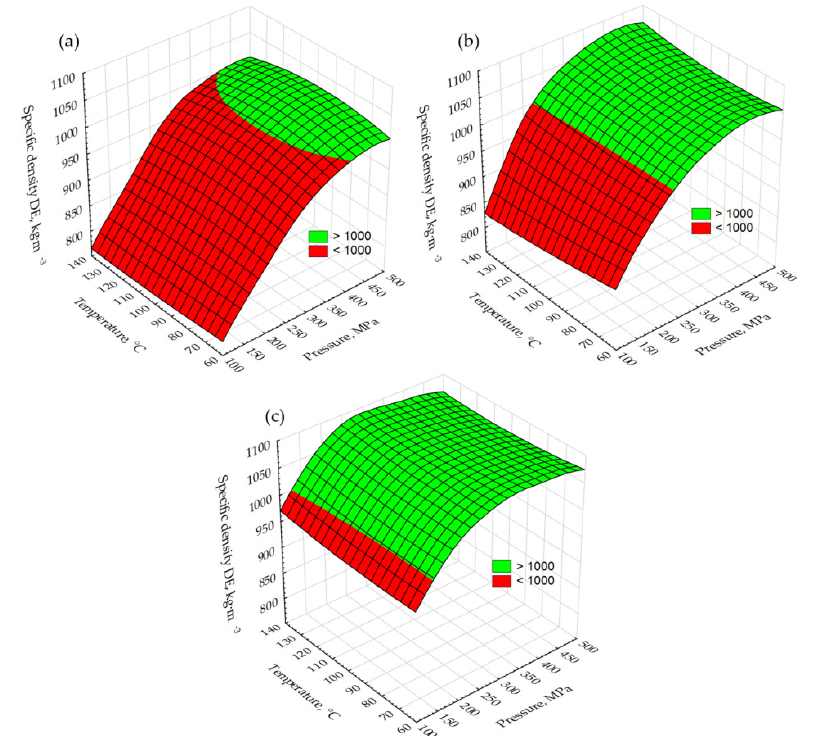
Figure 2. Changes of test pellet specific density DE due to the temperature of drying and compaction pressure: ( a ) dry sample, ( b ) moisture content at a level of 5%, and ( c ) moisture content at a level of 10%.